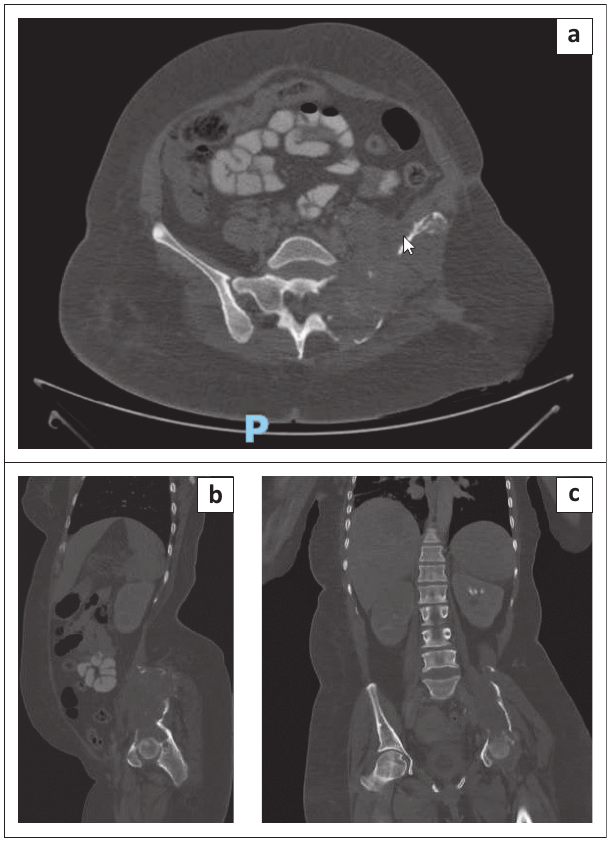
FIGURE 2: (a, b, c) Computerised tomography